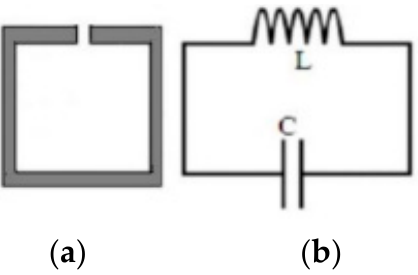
Figure 1. Model of SRR ( a ) and its corresponding circuit model ( b ).